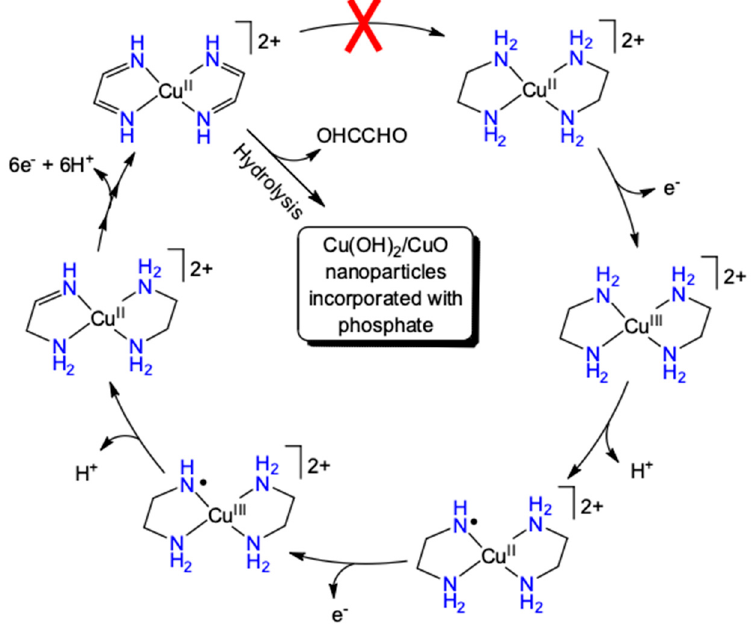
Figure 25. Mechanism proposed for the degradation of diamine complexes [94].